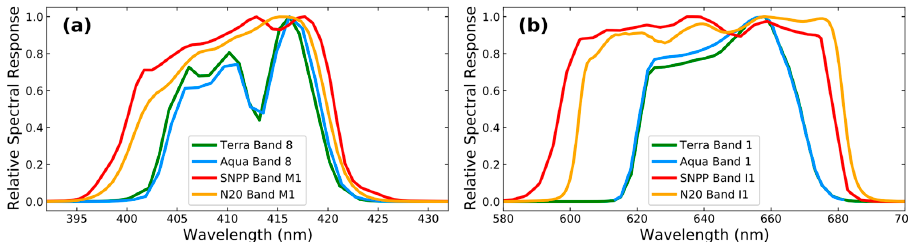
Figure 6. RSR comparison for bands in all four instruments near ( a ) 410 nm and ( b ) 640 nm. By including a correction to remove the calibration difference resulting from the use of different solar spectra by sensors A and B , the calibration difference between sensors A and B described by Equation (10) needs to be modified as,